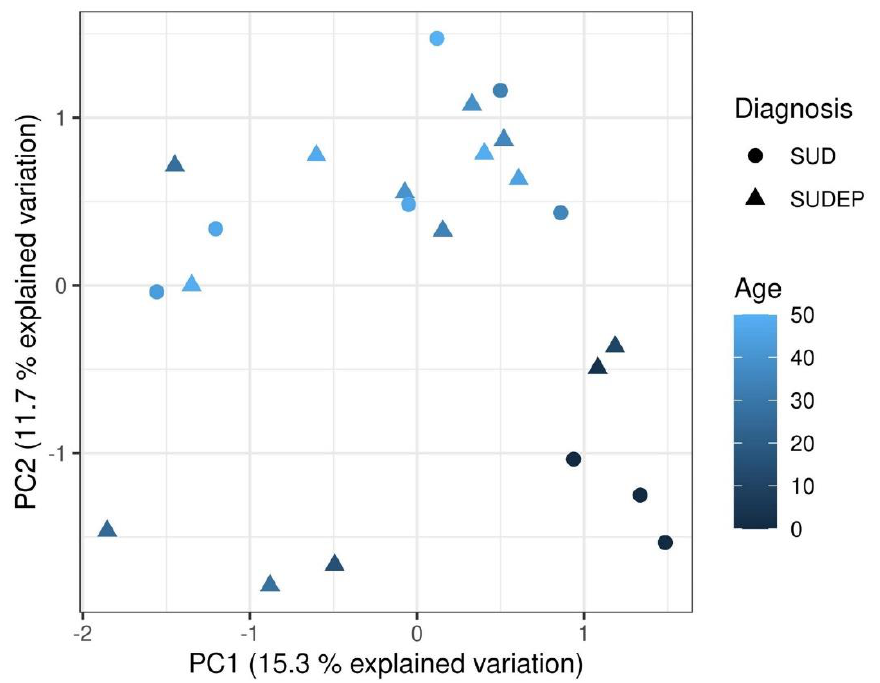
Figure 1. Principal component analysis plot. The principal component analysis was based on M- values. The samples are coloured according to age and the shape of the symbols shows diagnosis. PC: Principal component. SUD: sudden unexplained death. SUDEP: sudden unexpected death in